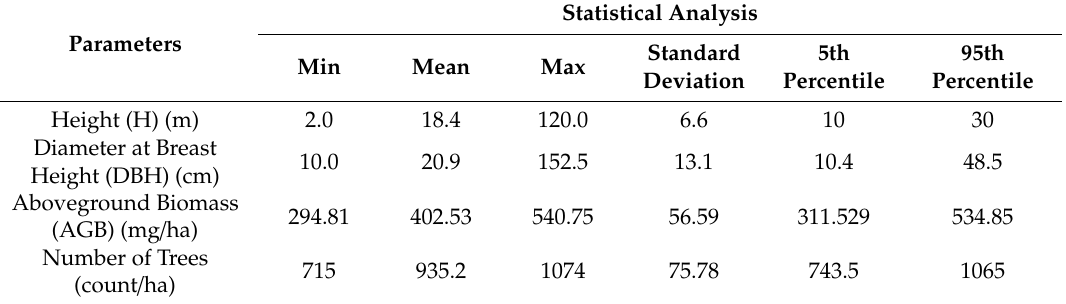
Table 1. Field inventory data statistics for the Robson Creek study site (Bradford et al. [27]).